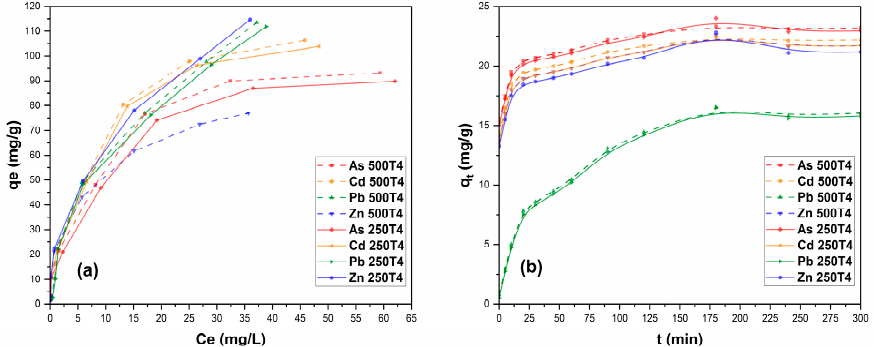
Figure 7. Langmuir adsorption isotherms ( a ) and pseudo-second order model ( b ), for T4 (250 and 500 µm).